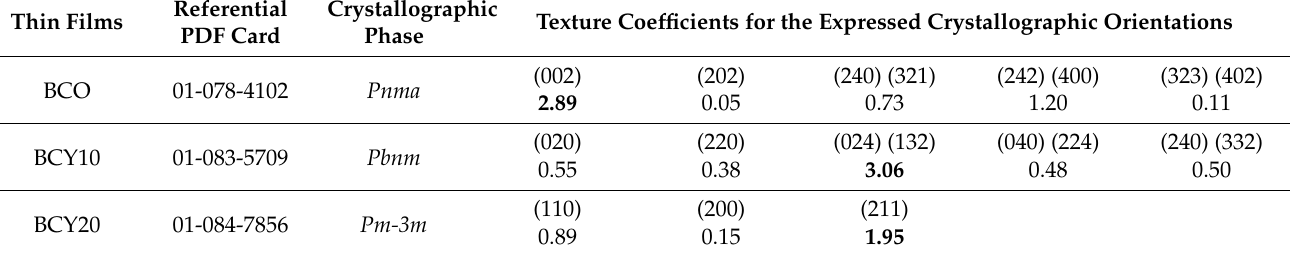
Table 2. Texture coefficients of the formed thin